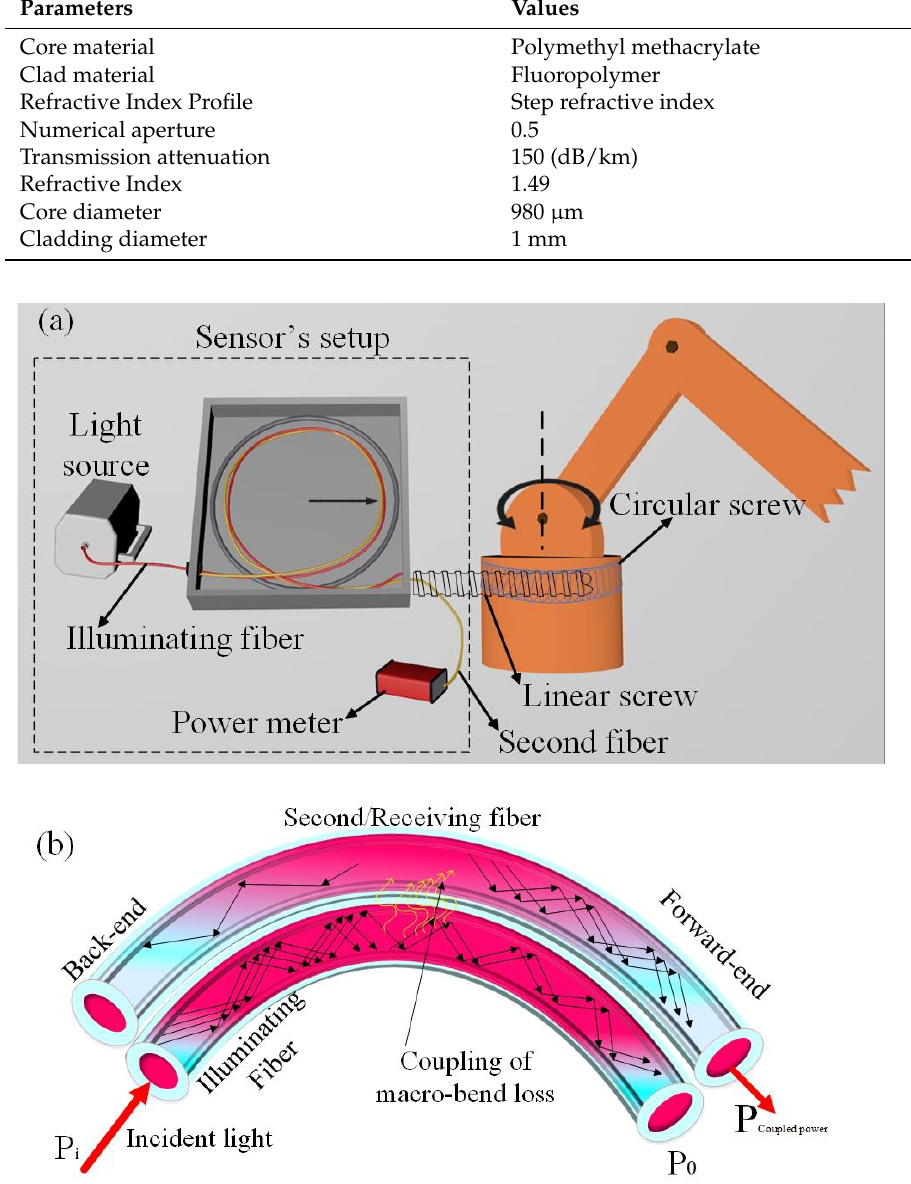
Figure 1. Schematic diagram of the rotational sensor. ( a ) The sensor is integrated into a robot for the rotational movement assessment, ( b ) the schematic diagram of the sensor’s working principle. Table 1. The characteristic parameter of the Mitsubishi SK-40 PMMA fiber.